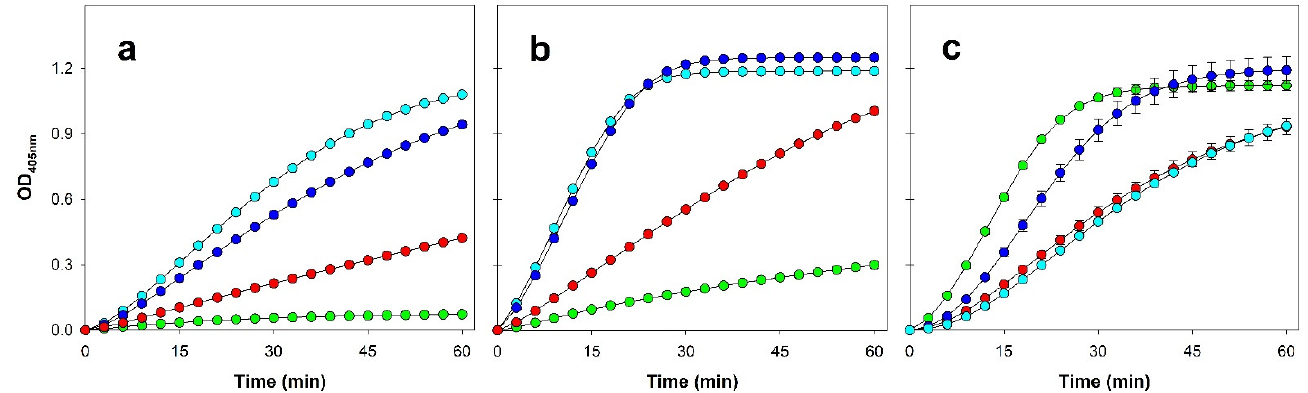
Figure 5. Effect of ions on HSA ( a ), PPA ( b ) and AOA ( c ) activity. The enzymatic activity was measured as the absorbance of the solution at 405 nm, in the absence of ions (green circles), in the presence of calcium (red circles), chloride (blue circles) or both ions (cyan circles).